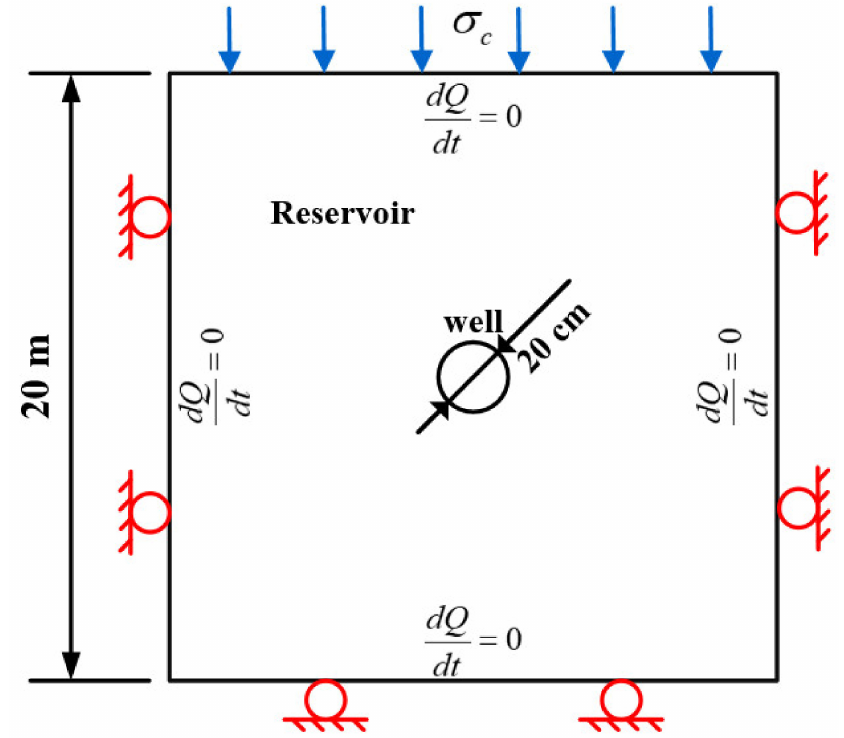
Figure 3. Geometric model and boundary